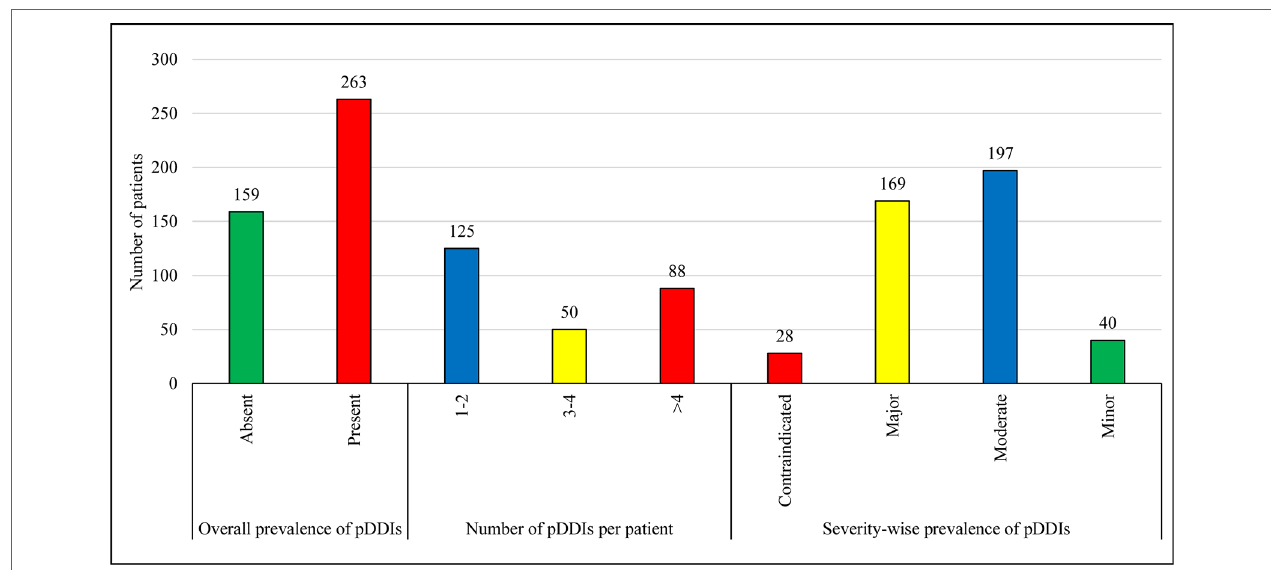
FIGURE 1 | Overall-prevalence is the occurrence of at least one pDDI irrespective of severity type. The total number of UTI patients was 422. Therefore, the overall prevalence of pDDIs is 62.3% (263 out of 422). Data are presented in the form of frequencies. The prevalence of pDDIs has also been reported on the basis of severity levels. pDDIs, potential drug-drug interactions.